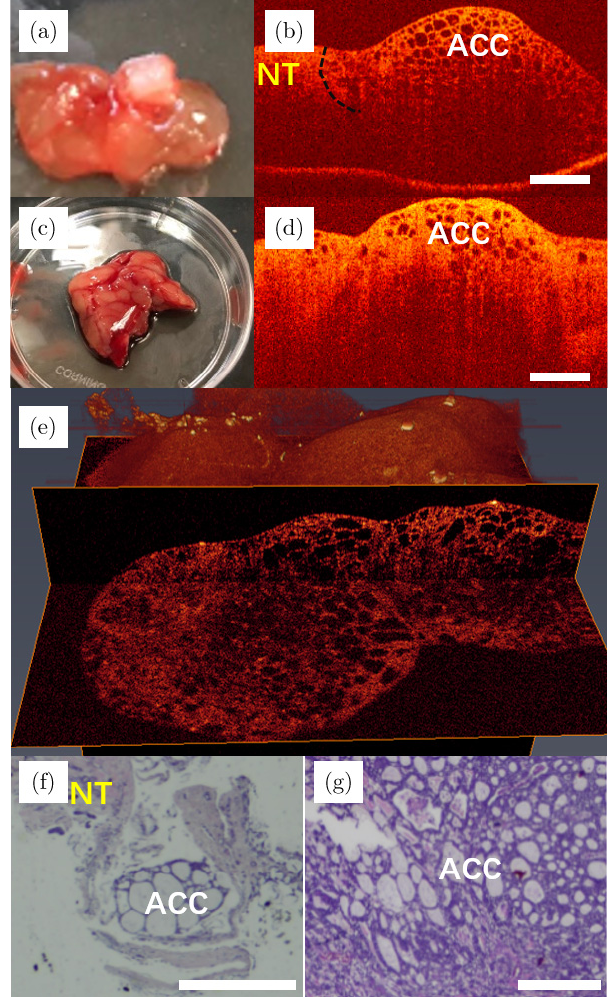
Fig. 2. Images of adenoid cystic carcinoma. Panels (a) and (c) are photos, and panels (b) and (d) are the 2D OCT images of adenoid cystic carcinoma of the palate tissue from two patients, respectively. Panel (e) is the 3D OCT image of the adenoid cystic carcinoma. Panels (f) and (g) are their corresponding histopathological images. ACC: adenoid cystic carcinoma and NT: normal tissue.